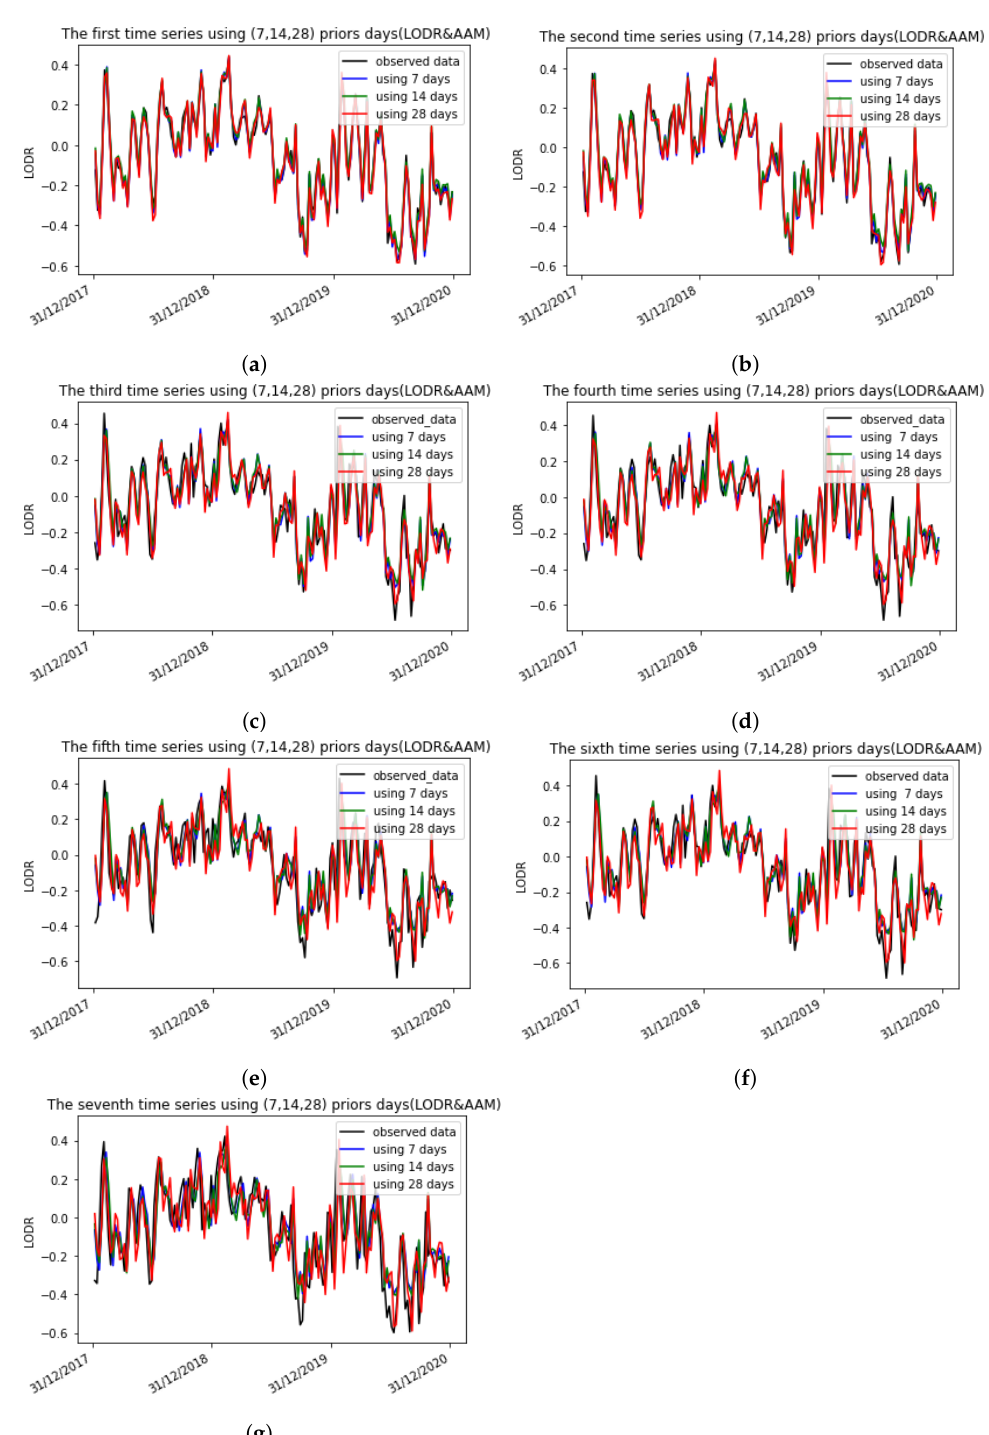
Figure 9. The seven time series using 7, 14, and 28 prior days with the LODR + AAM using the 1D CNN. Each plot represents, respectively, the first and the second to the seventh prediction days using different input sizes before and after introducing the AAM. The number of predicted weeks covers 3 years (2017, 2018, 2019). ( a ) The first time series using 7, 14, 28 prior days (LODR + AAM); ( b ) The second time series using 7, 14, 28 prior days (LODR + AAM); ( c ) The third time series using 7, 14, 28 prior days (LODR + AAM); ( d ) The fourth time series using 7, 14, 28 prior days (LODR + AAM); ( e ) The fifth time series using 7, 14, 28 prior days (LODR + AAM); ( f ) The sixth time series using 7, 14, 28 prior days (LODR + AAM); ( g ) The seventh time series using 7, 14, 28 prior days (LODR +